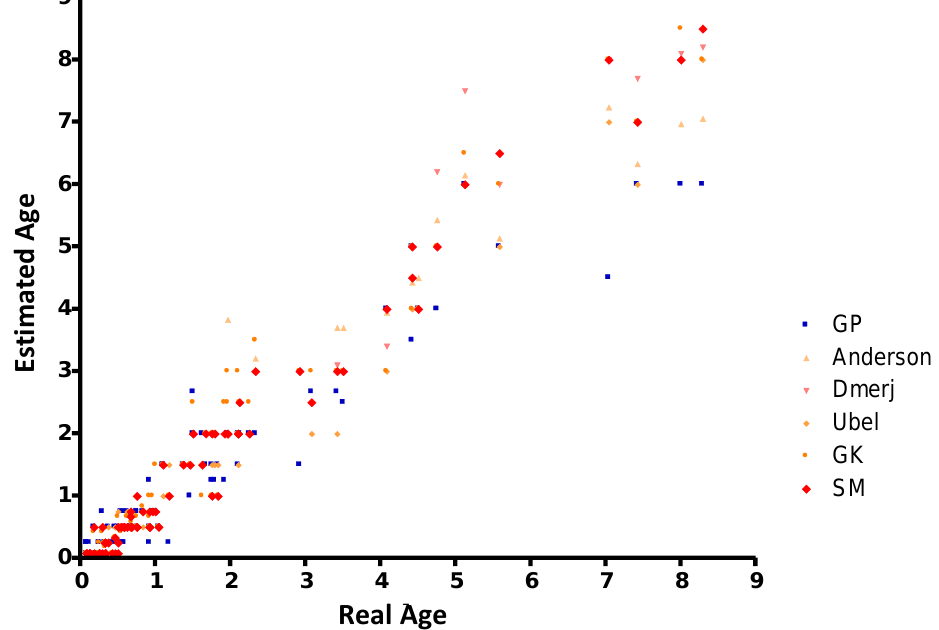
Figure 1. Real age and age estimated by the different methods. Notes. GP: Greulich and Pyle, GK: Gustafson and Koch, SM: Schour and Massler.